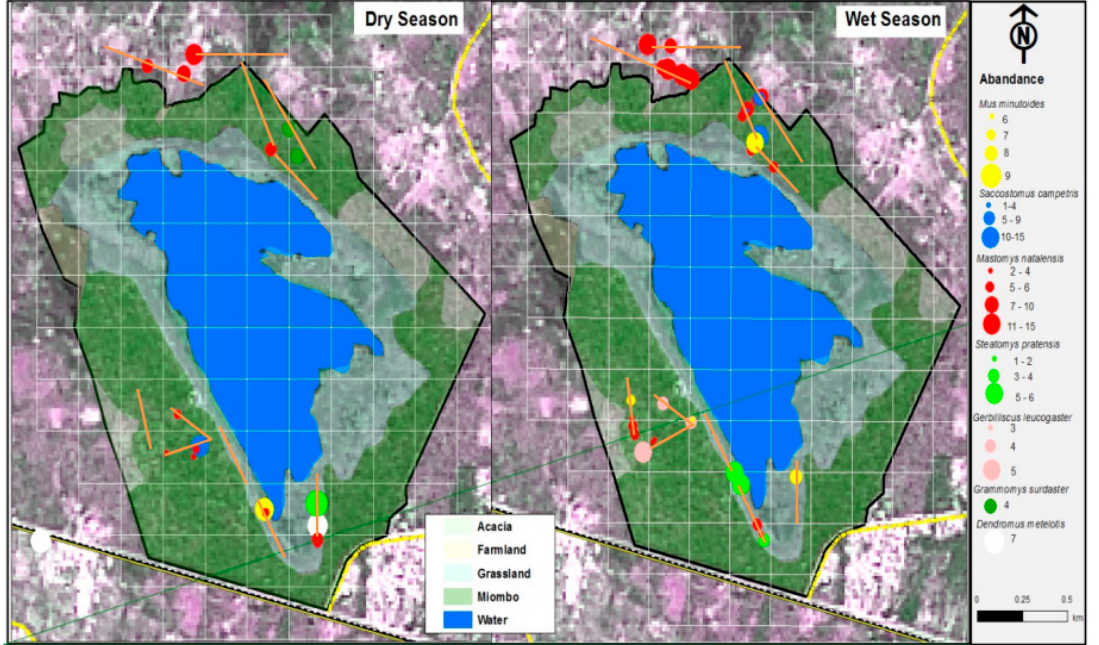
Figure 2. Distribution of rodents and their abundance in dry and wet seasons across four habitat types in the Chembe Bird Sanctuary landscape, Zambia, 2018, and 2019. Points in Figure 2 represent the trap sites where captures (samples) were made, and the sizes of points signify the number of rodent captures. The transects along which samples were collected are shown as solid brown lines.